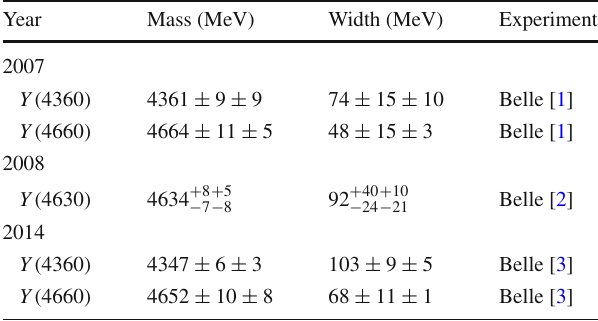
Table 1 The masses and widths from the different experiments